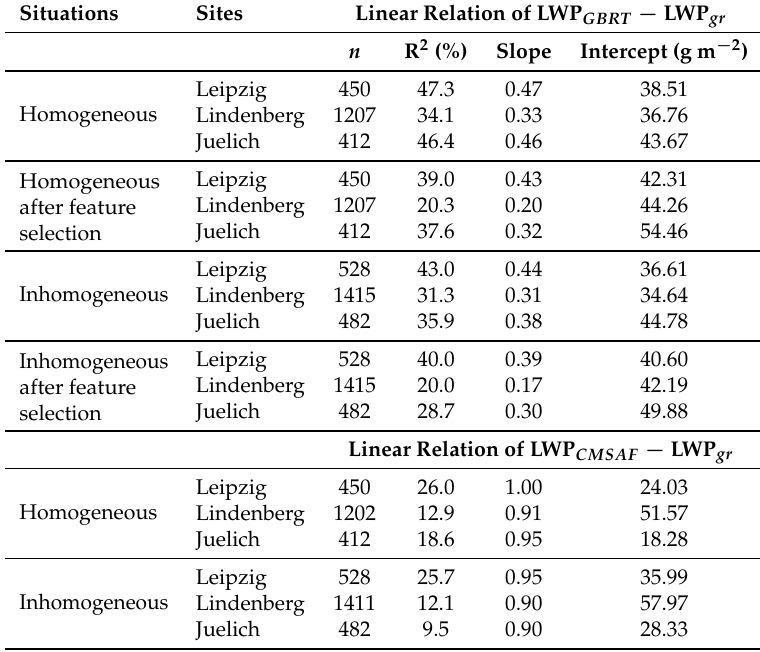
Table A1. Summary of the relation between LWP GBRT and LWP gr for test data for each site in different situations. n is the total number of samples.